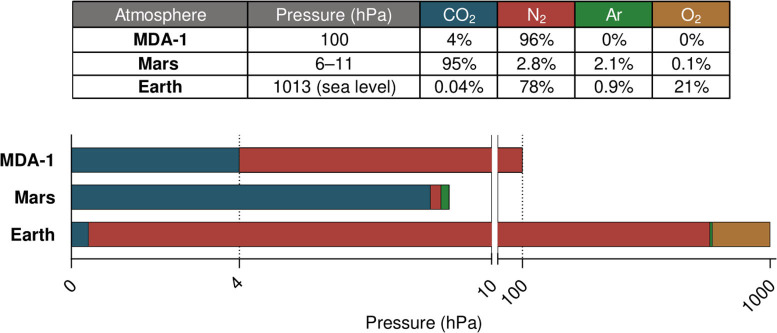
Comparison of Earth, Mars, and MDA-1 atmospheres. The scale of the bar graph is linear over each of both segments (0–10 and 10–1,020 hPa). Gas proportions in the table are given in volume percent; data for Mars are from Franz et al. (2017), those for Earth from NOAA et al. (1976) and NOAA (2020).